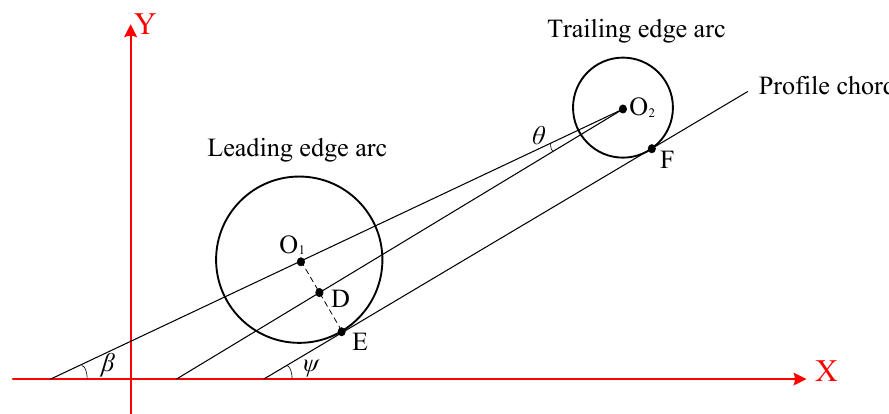
Figure 8. Analysis diagram of the mathematical model for the twist angular position of the profile.